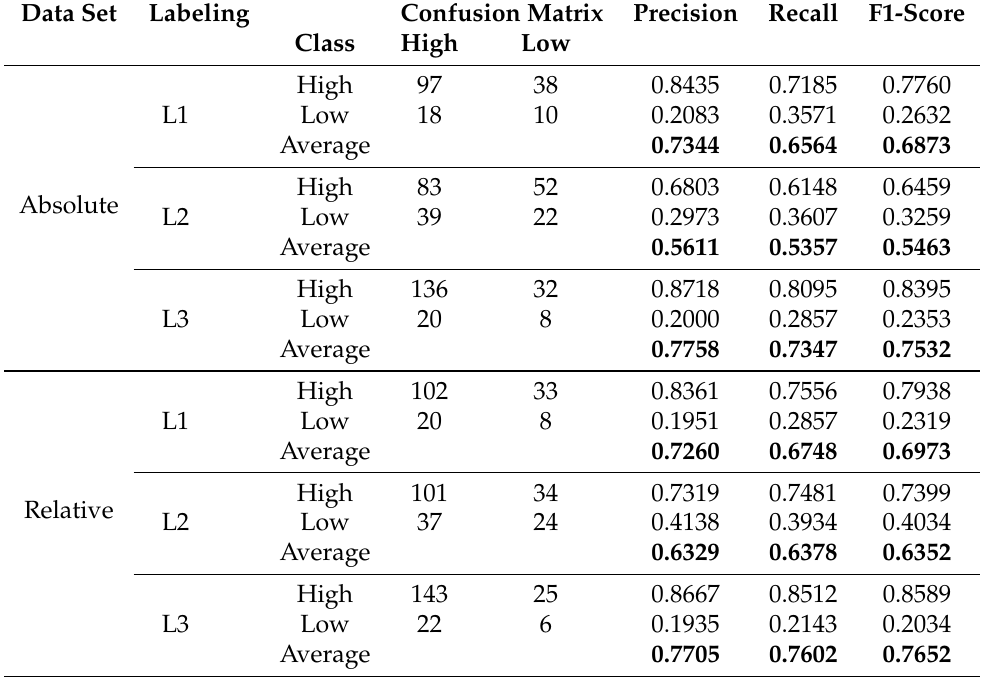
Table 9. Summary of classification results for the level of of pleasure. The values marked bold are weighted averages of precision, recall and F1-score.